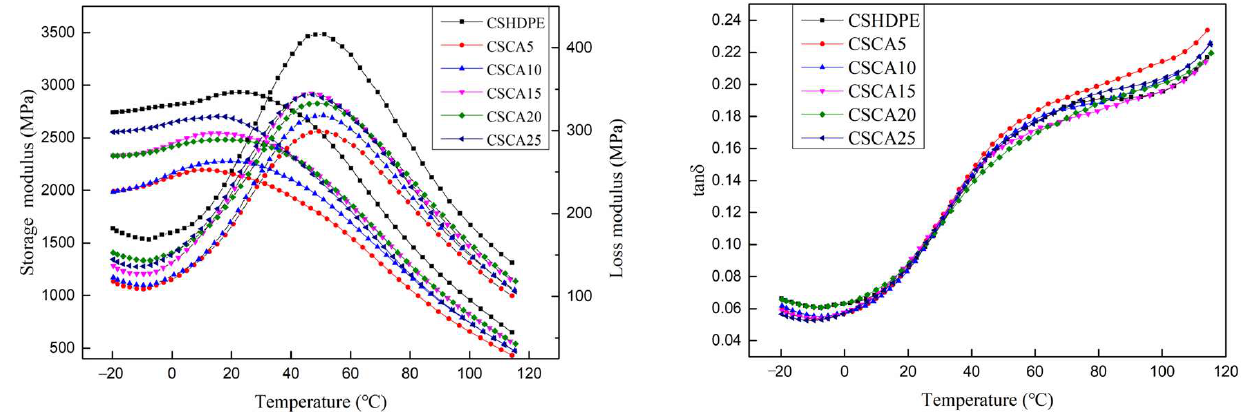
Figure 6. Dynamical mechanic properties of core–shell structured WPCs.